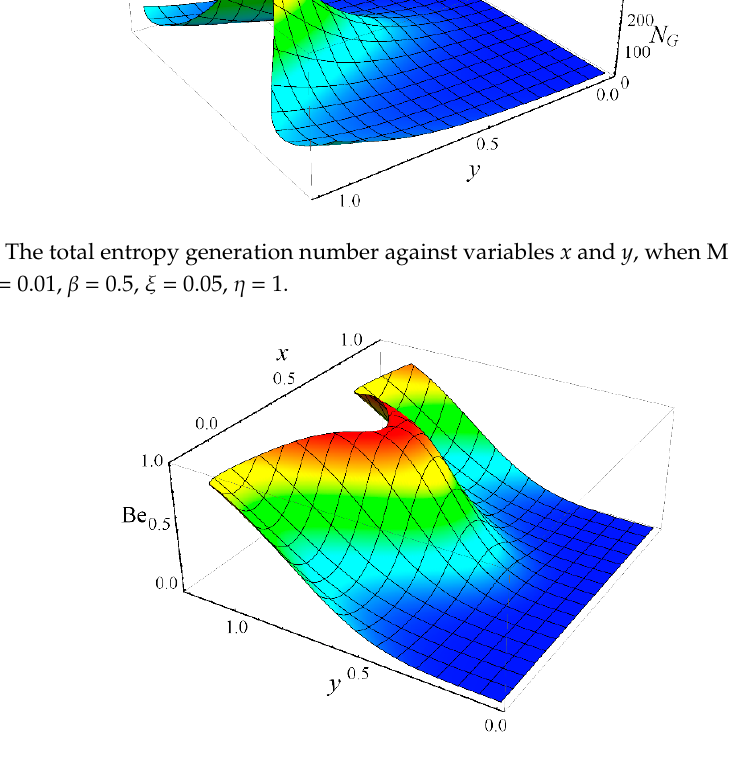
Figure 24. The Bejan number against variables x and y , when M = Br = 1, ε = 0.2, α = 0.1, ϕ = 0.01, β = 0.5, ξ = 0.05, η = 1.